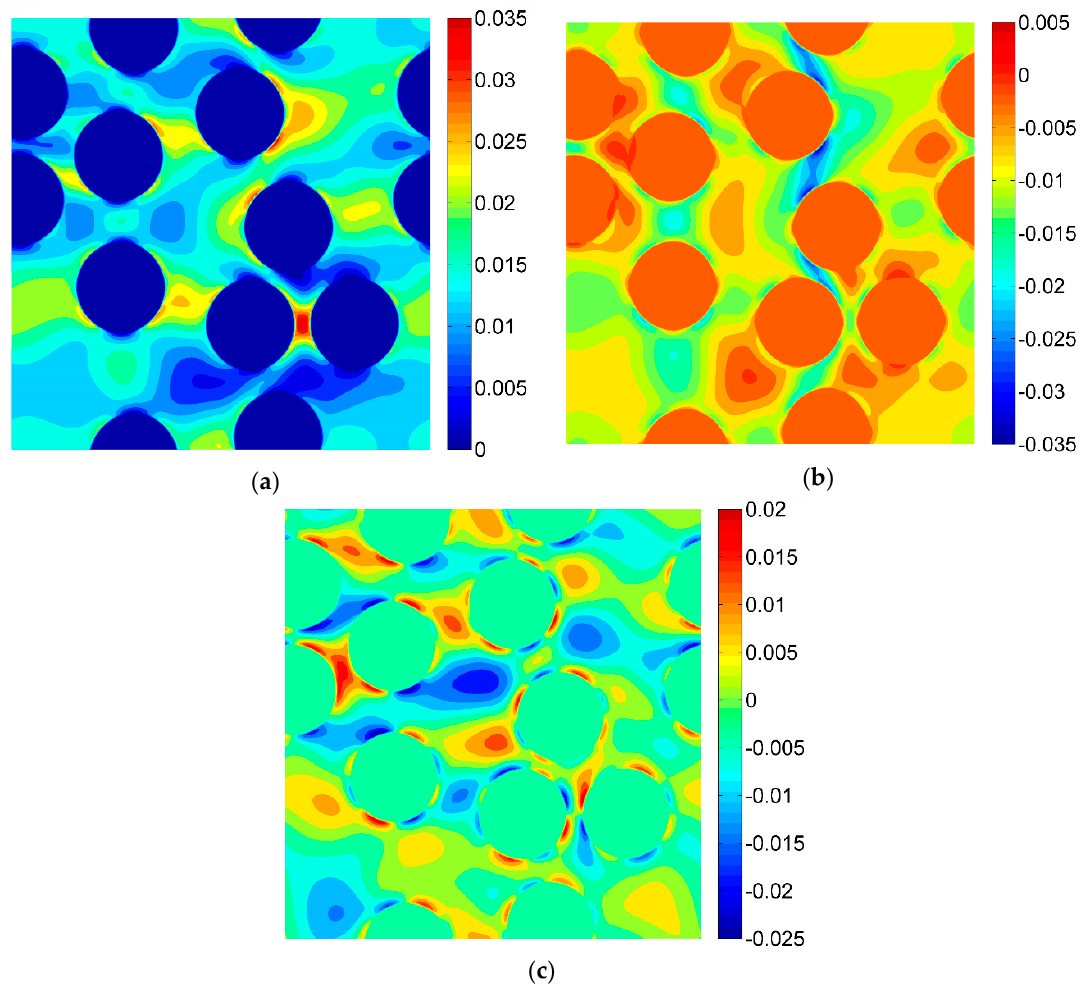
ε ε 11 ; ( b ) 22 ; ( c ) 12